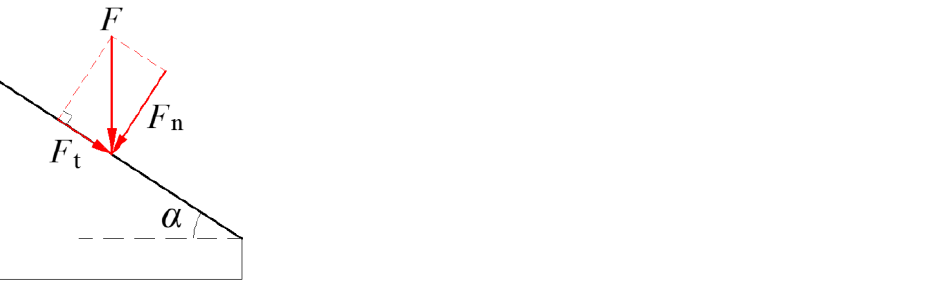
Figure 4. Decomposition of vertical load acting on the upper boundary in Figure 3b. According to the principle of elasticity [39], the stress components induced by normal or tangential loads are given in Equations (2) and (3), respectively.